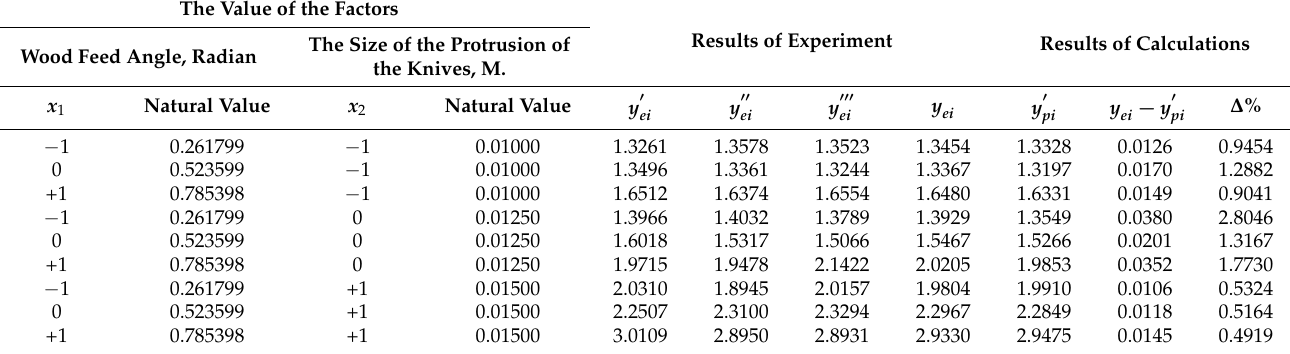
Table 1. Statistical indicators of the power consumption.